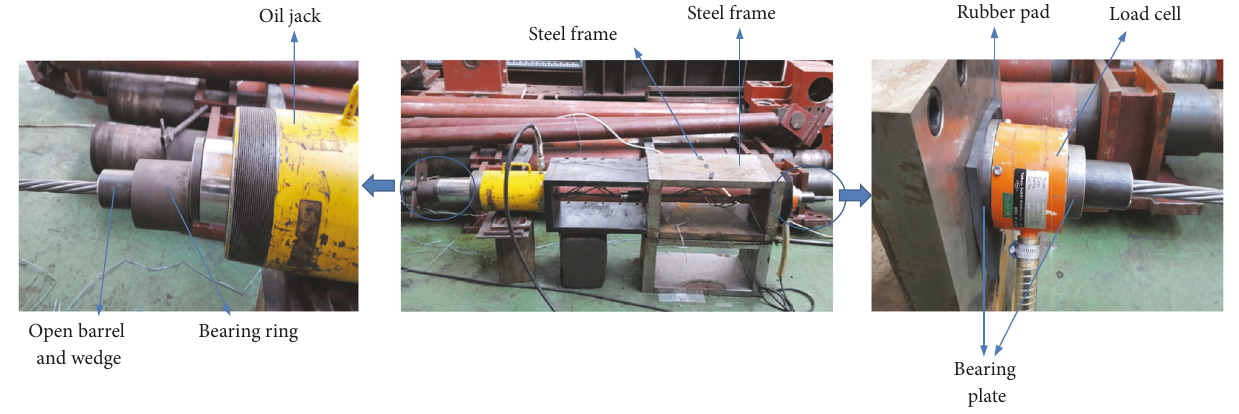
Figure 1: Test setup for loading and prestressing